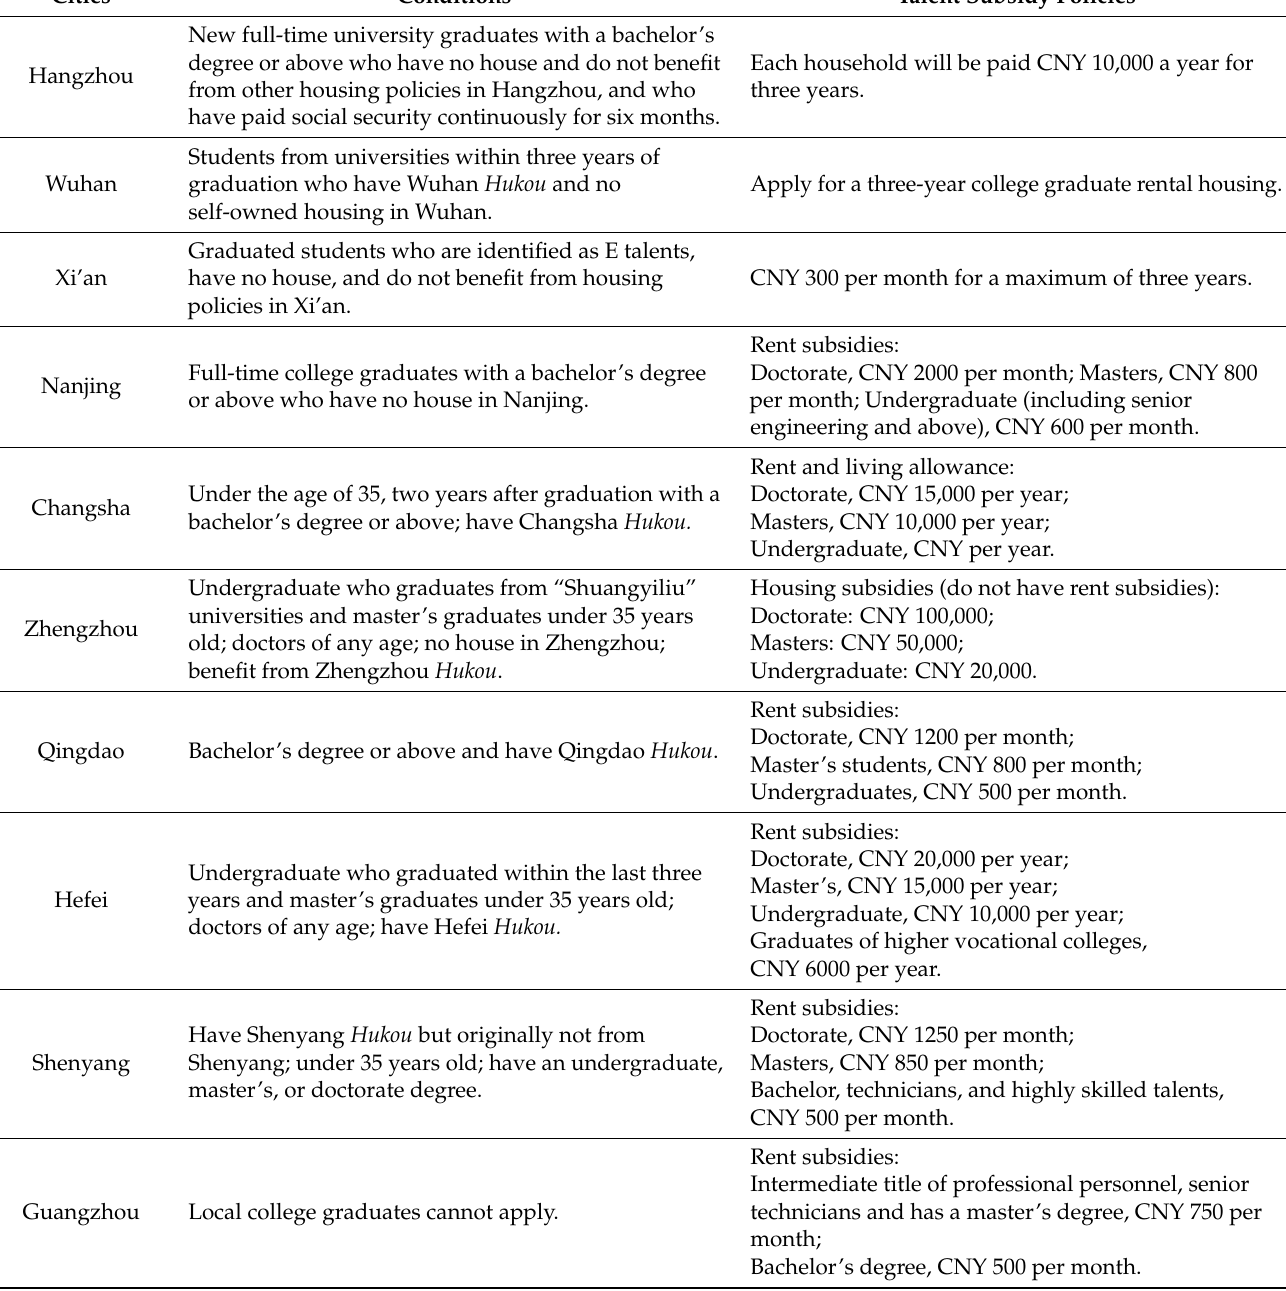
Table A1. Ten cities’ talent subsidy policies in